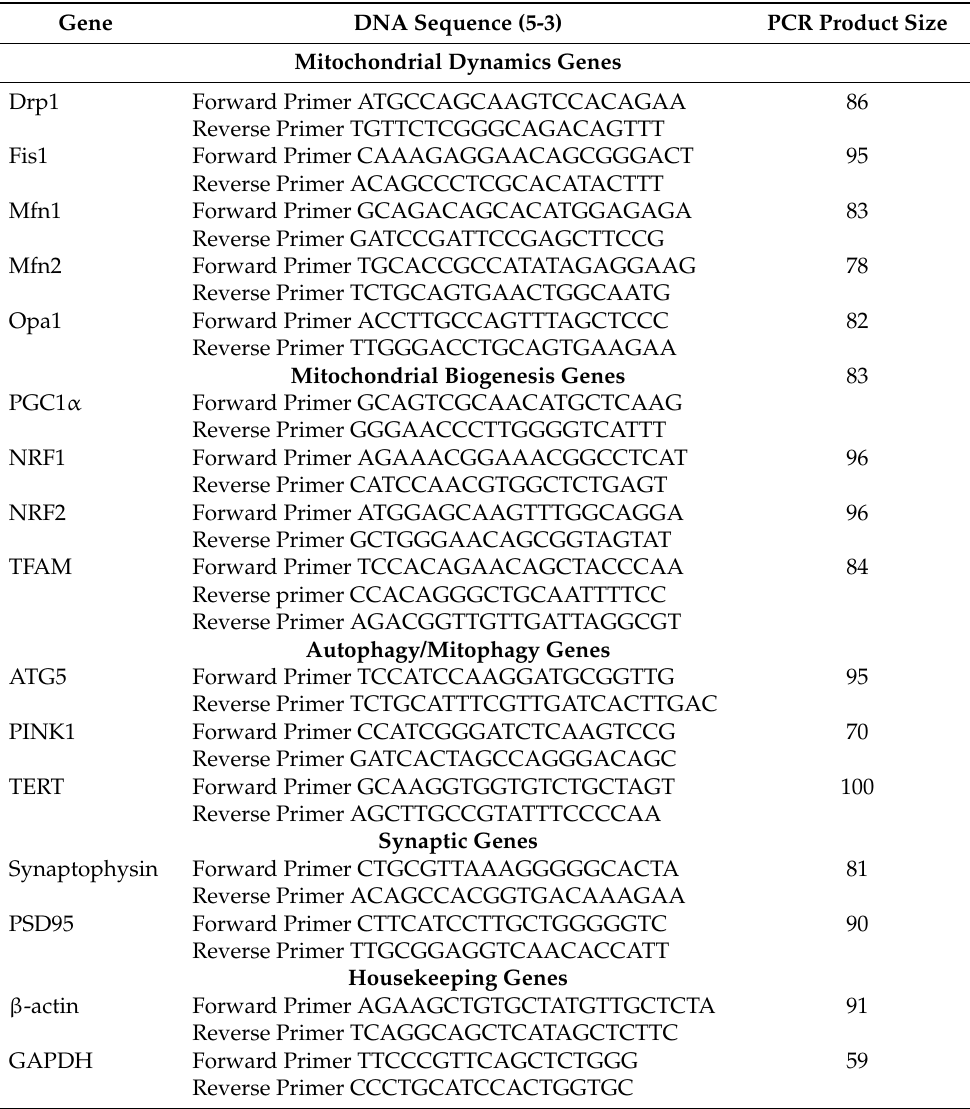
Table 1. Summary of qRT-PCR oligonucleotide primers used in measuring mRNA expressions in mitochondrial dynamics, mitochondrial biogenesis, synaptic, autophagy, and mitophagy genes in chaya chow-fed TH and regular chow-fed TH